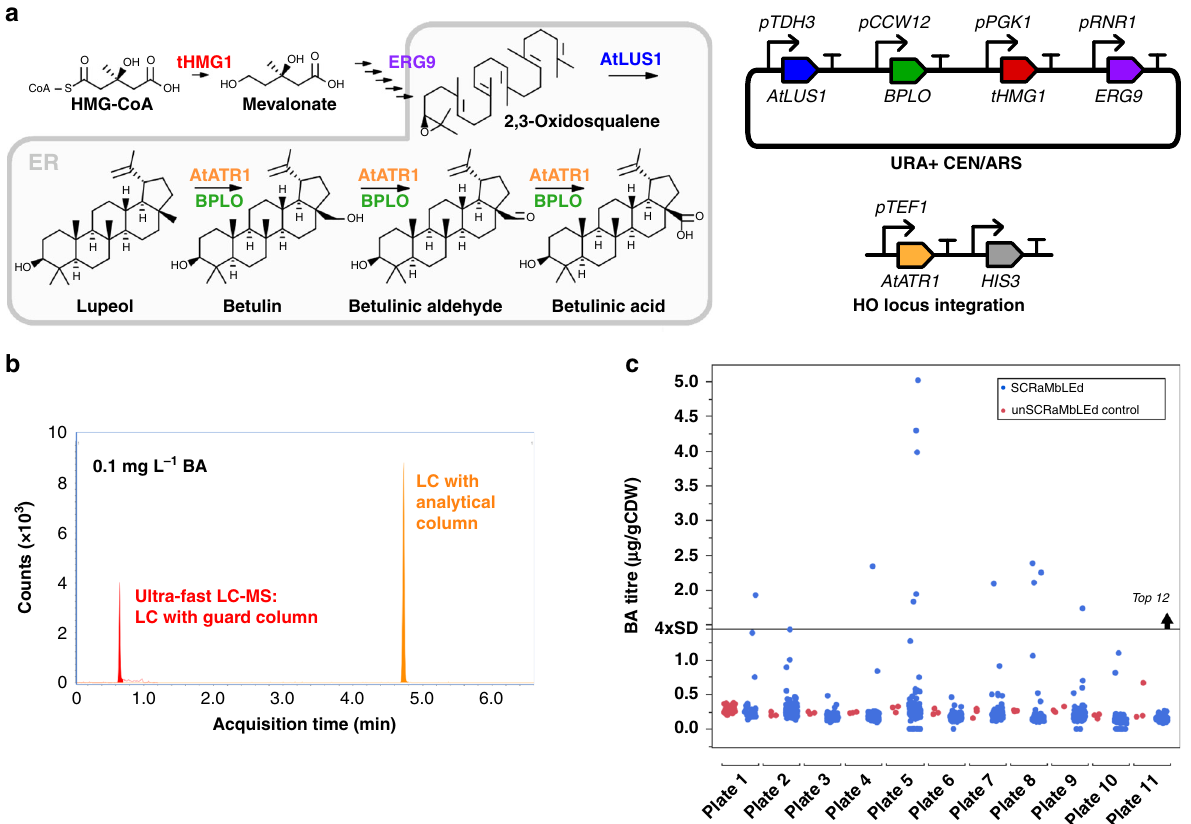
Fig. 1 SCRaMbLE of a betulinic acid-producing strain followed by rapid screening yields a diverse library. a BA is synthesised by redirecting fl ux from the endogenous mevalonate pathway (left, top row) using three heterologous enzymes (AtLUS1, a lupeol synthase from Arabidopsis thaliana ; BPLO, a cytochrome P450 from Betula platyphylla ; and AtATR1, a P450 reductase from Arabidopsis thaliana ). tHMG1 and ERG9 were additionally introduced to increase fl ux down the mevalonate pathway. Four genes ( AtLUS1 , BPLO , tHMG1 , and ERG9 ) were expressed from a URA + CEN/ARS plasmid while AtATR1 was integrated into the genome at the HO locus on chromosome IV (right). b Ultra-fast LC-MS utilises only a guard column for separation (red) which analyses each sample with a retention time of 40 s compared to ~4.8 min for conventional LC-MS (orange). c Eleven plates were run with ultra-fast LC-MS over 26 cumulative hours split across 2.5 days. Forty pre-SCRaMbLE control samples (red) were present in the fi rst plate and three in every subsequent plate. Standard curves were run at the start and the end of the screen. After screening 964 SCRaMbLE colonies a minimum OD 600 cut off of 0.1 was applied. 914 SCRaMbLE strains exceeded this threshold and were plotted (blue). A threshold of above ×4 control standard deviations was set to identify signi fi cantly improved strains. Source data are provided as a Source Data fi